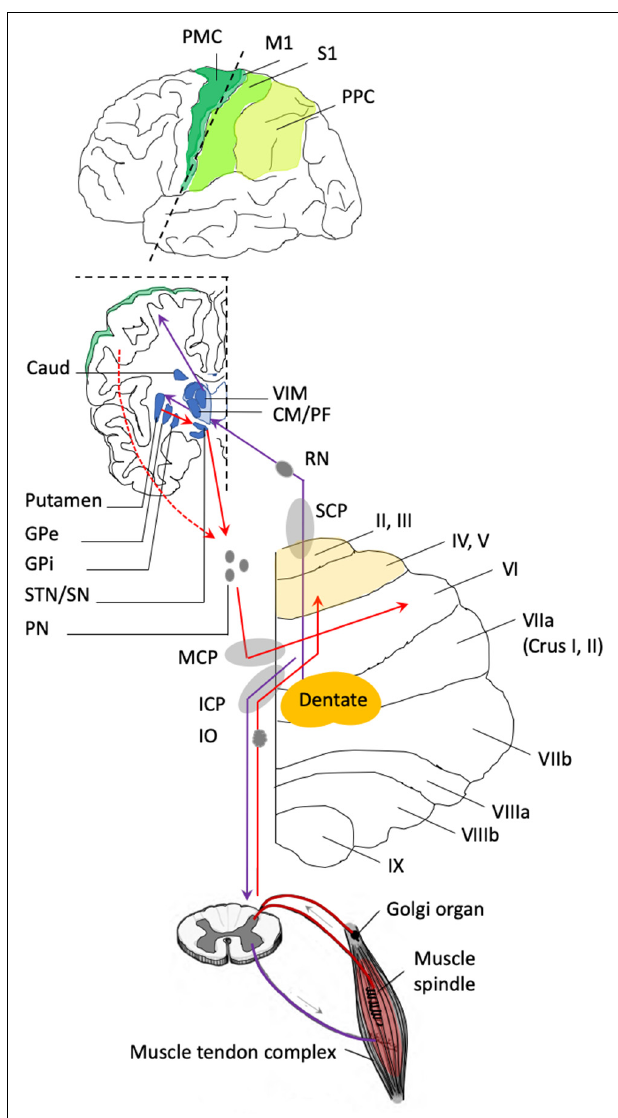
FIGURE 2 | Anatomical connections of the cerebellum relevant to the forward model. The anterior lobe of the cerebellum is represented in light yellow and includes the lobules labeled from I to V. The posterior lobe of the cerebellum includes the lobules labeled from VI to IX. The functional connectivity of the cerebellum is organized in a series of loops, where the cerebellum receives inputs from the cerebral cortex, the striatum, and the spinal cord, and in return, the deep cerebellar nuclei send projections back to these same regions. Incoming pathways to the cerebellum are represented in red. The middle cerebellar peduncle (MCP) contains the fibers that project from the cerebral cortex and the striatum (caudate (caud) and putamen) to the posterior lobe of the cerebellum through a relay in the pontine nuclei (PN). The cerebellum receives input from a large number of cortical areas, including regions associated with motor preparation and execution (represented in green; PMC, premotor cortex; M1, primary motor cortex; S1, primary somatosensory cortex; PPC, posterior parietal cortex). The cerebellum also receives inputs from the basal ganglia (represented in blue). The subthalamic nucleus (STN) is an additional relay between the striatal output [globus pallidum pars interna (GPi) and pars externa (GPe)] and the pontine nuclei. Also, the anterior cerebellum receives sensory